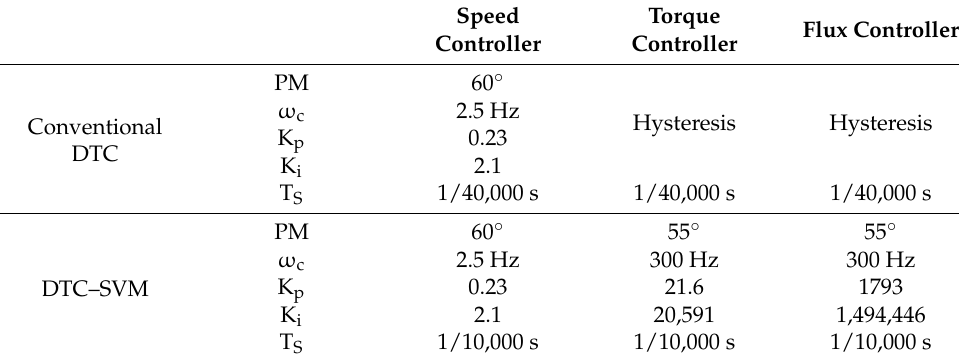
Table 5. Parameters of the